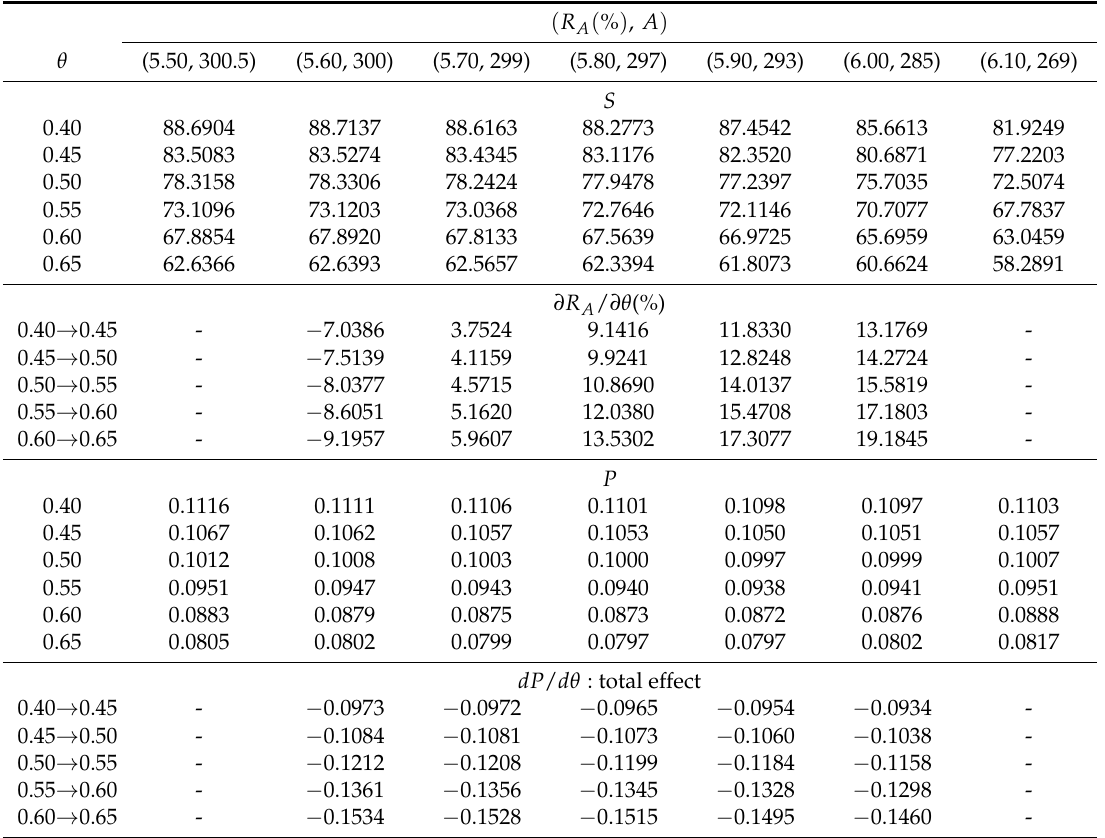
Table 4. Responsiveness of asset-side interest margin (asset interest rate) and default risk to buying distressed assets based on Equations (16) and (18) 1